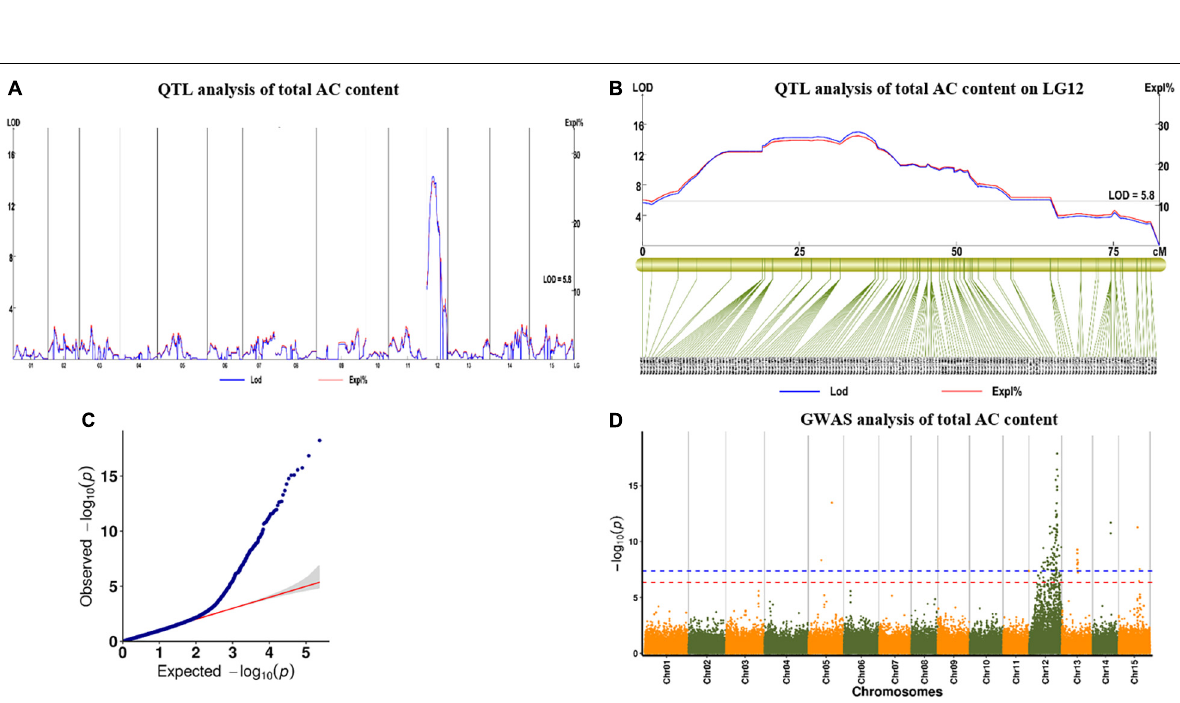
Frontiers in Plant Science |